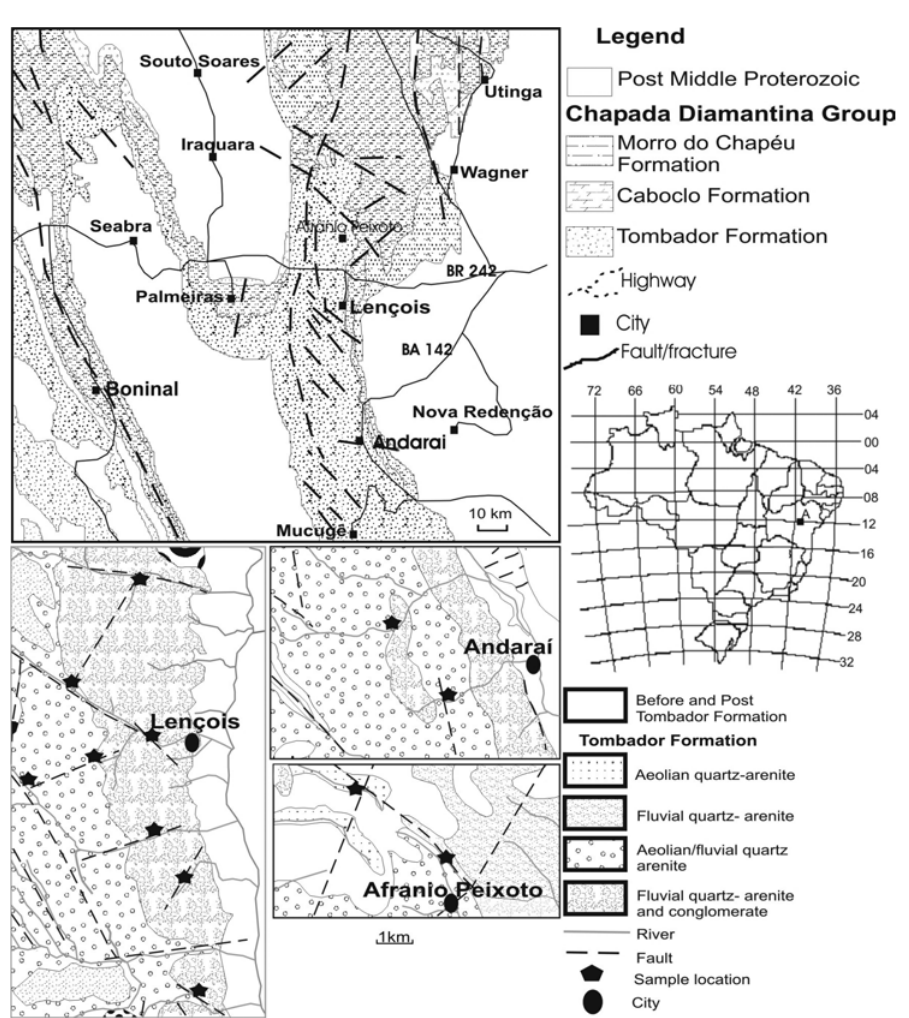
Fig. 1 – Regional geologic map of the Espinhaço Range and the Chapada Diamantina area showing the location of the studied outcrops (modified from Barbosa and Dominguez 1996). Detailed geologic map with the location of the samples analyzed in this study (modified from Bonfim and Pedreira 1990 and Guimarães and Pedreira